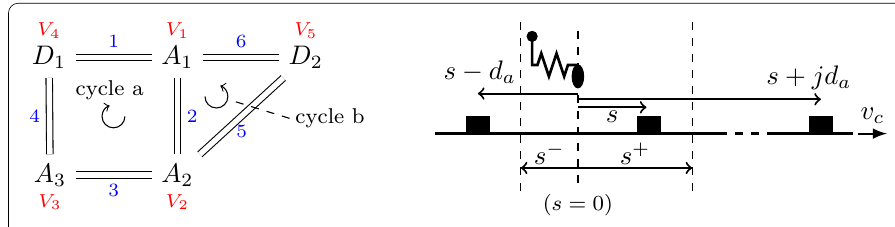
Fig. 3 Left: graph associated with the model Piazzesi–Lombardi’95. The vertex indices are given in red. The transition indices are given in blue. Right: Piazzesi–Lombardi’95 model parametrization. The position of the actin site corresponding to s = 0 is represented by a thick dashed